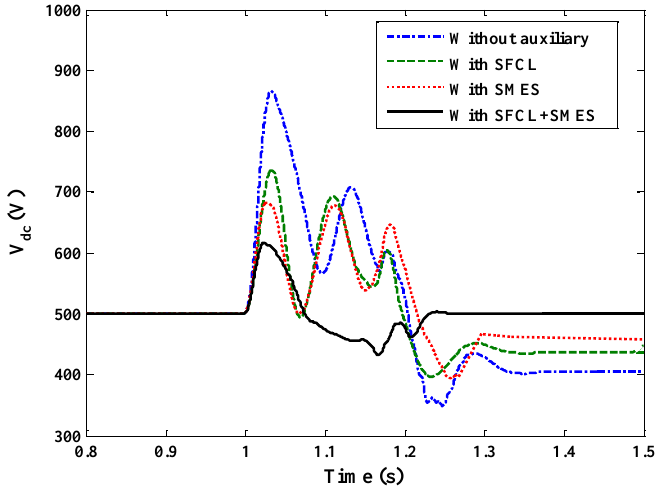
Figure 12. Characteristics of the DC-link voltage under the symmetrical fault.